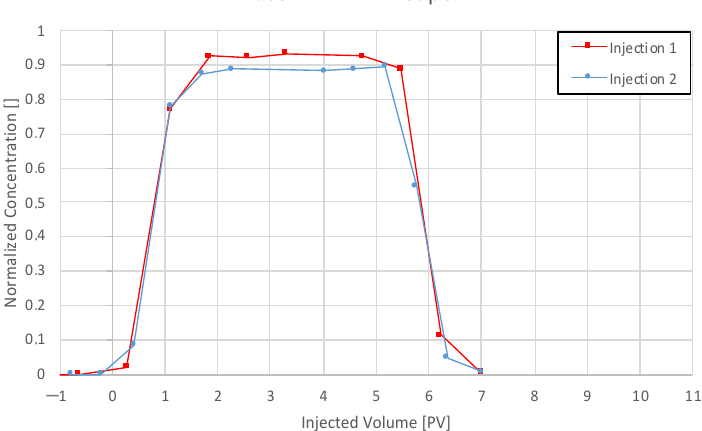
Figure 14. Tracer analysis for nanofluid (NF) B in the Keuper outcrop’s core. The concentration history is almost parallel for both injection steps.